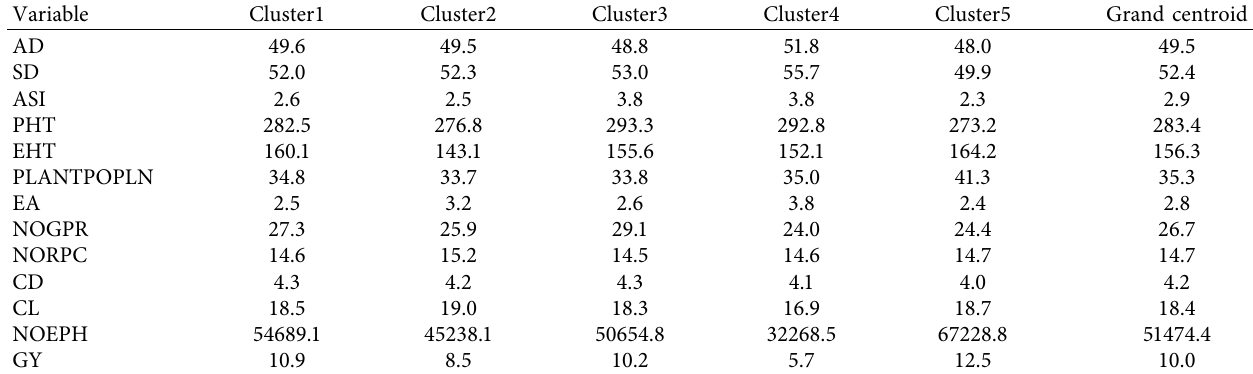
Table 6: Centroid of clustering of 26 genotypes evaluated for agro-morphological